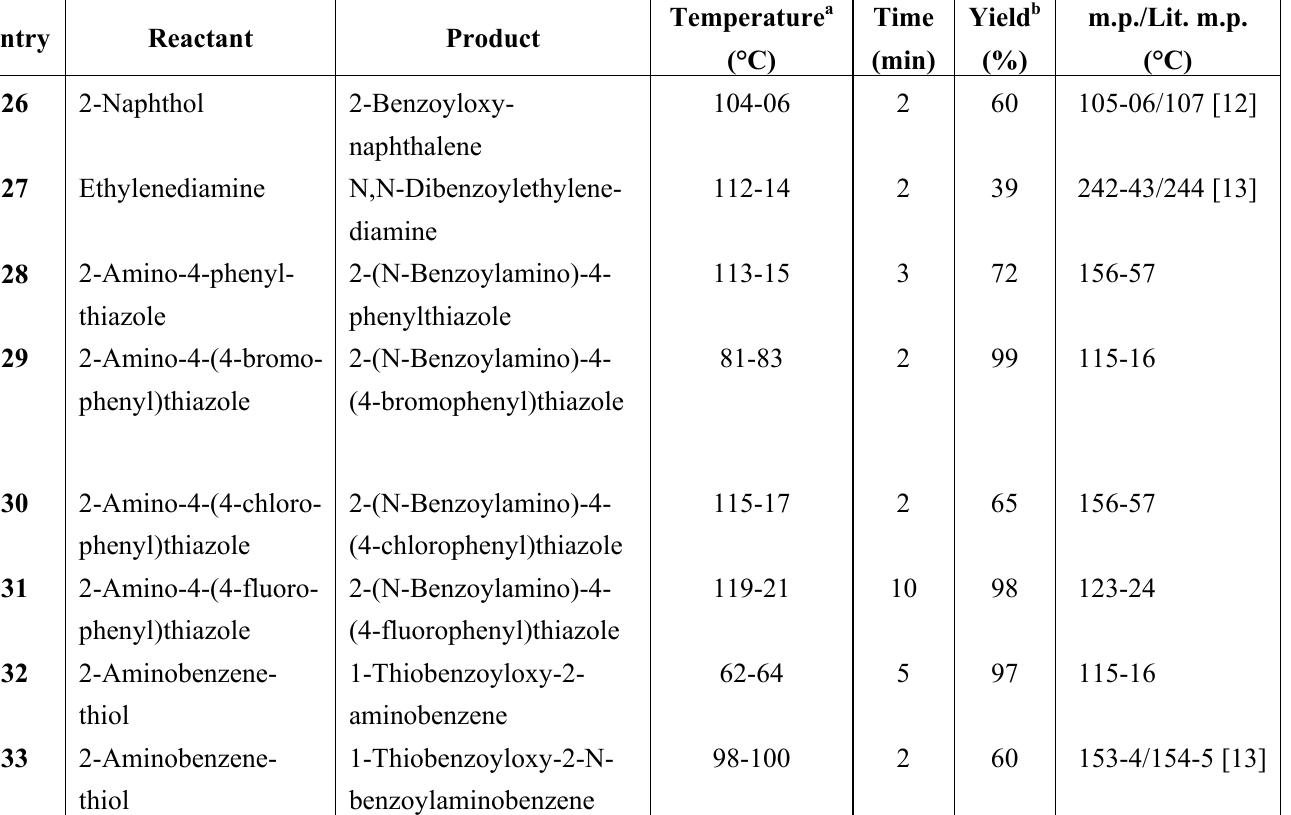
Figure 1. Effect of microwave power on the benzoylation of aniline and 2-nitroaniline